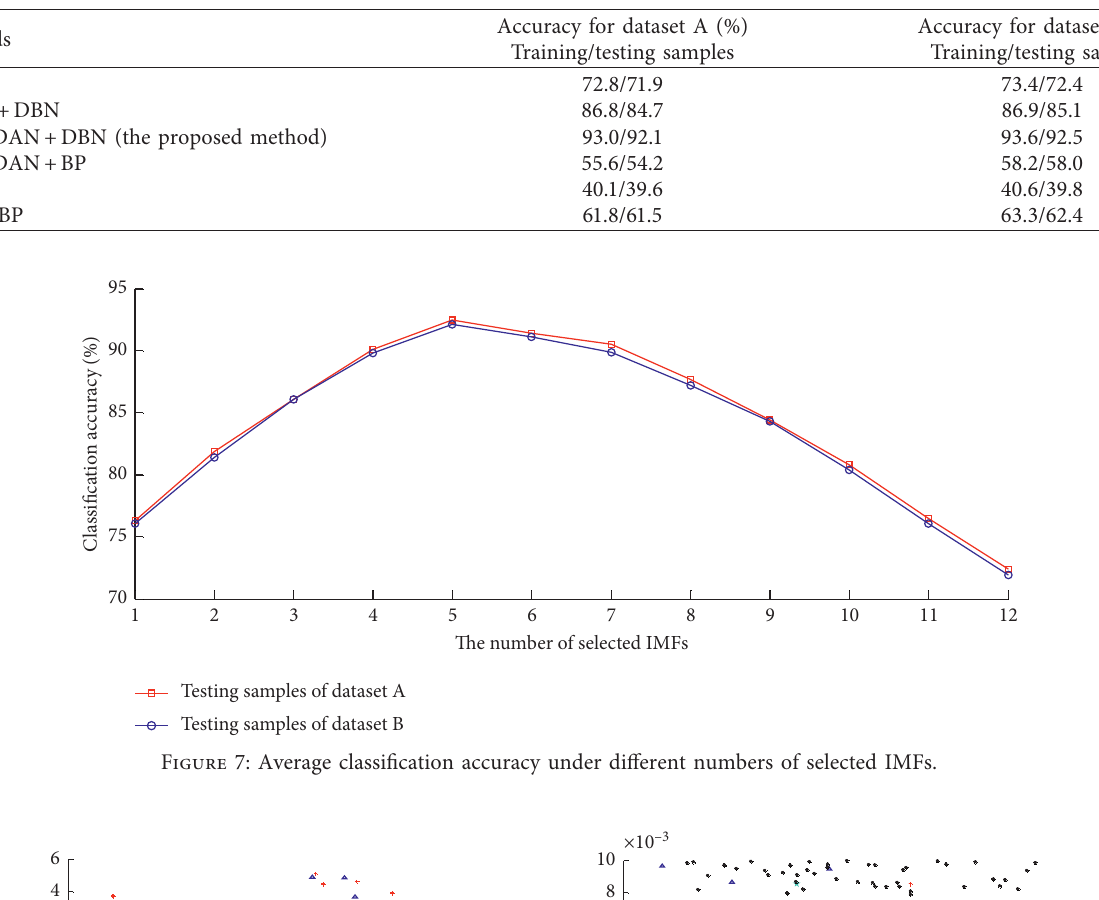
Table 4: Accuracy comparison for the six methods.